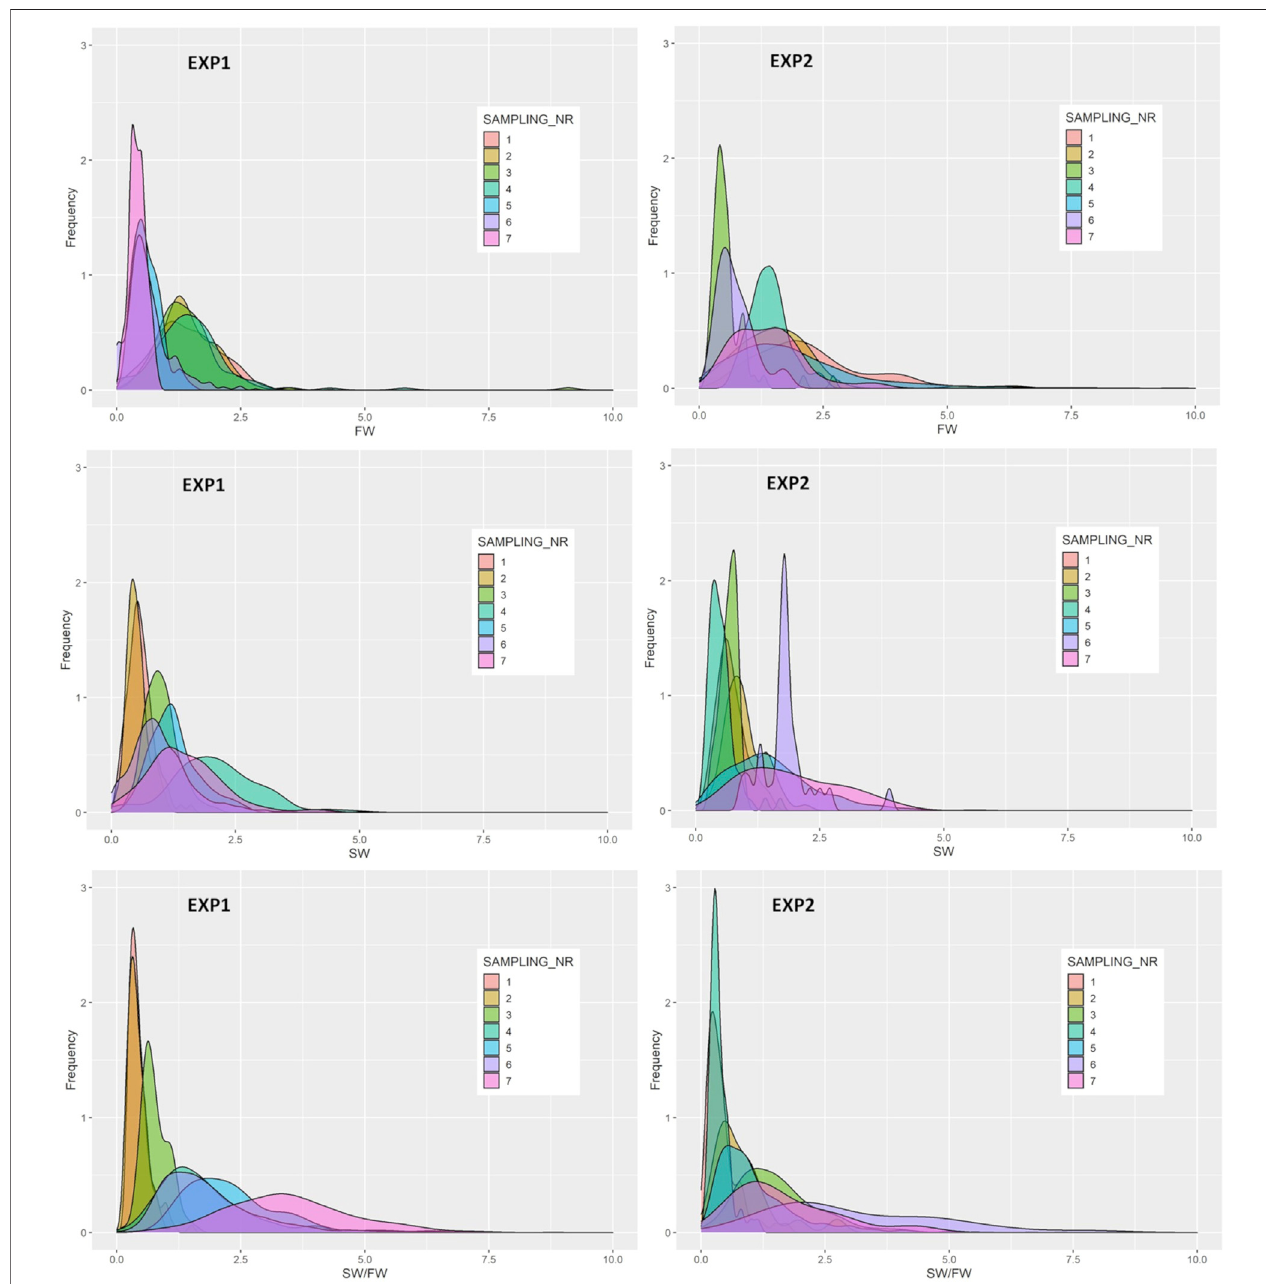
FIGURE 4 | Frequency distributions ofthe relative expression of freshwater (FW) and the seawater (SW) variants and their ratio (SW/FW) determined by two genes with effect on the Na + K + ATPase activity in the gills at each of the seven samplings of EXP1 and EXP2.